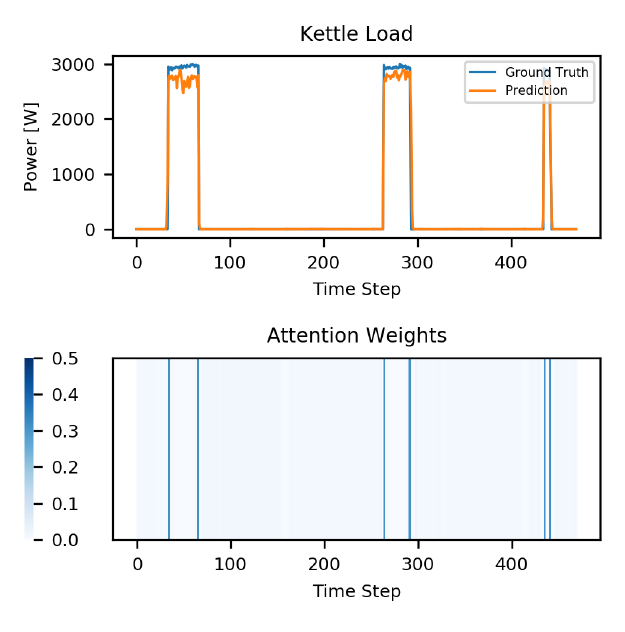
Figure 7. UK-DALE kettle load and the heatmap of the attention weights at 6 s